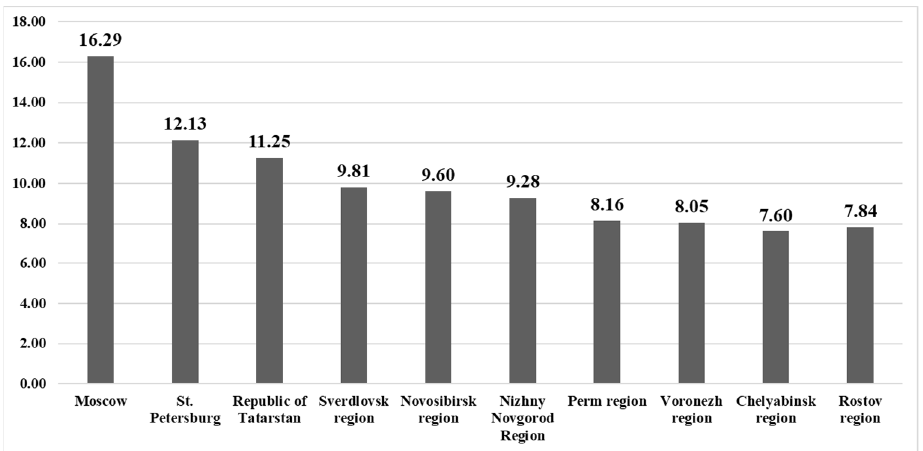
Figure 1. Additive FE index for Russian regions.